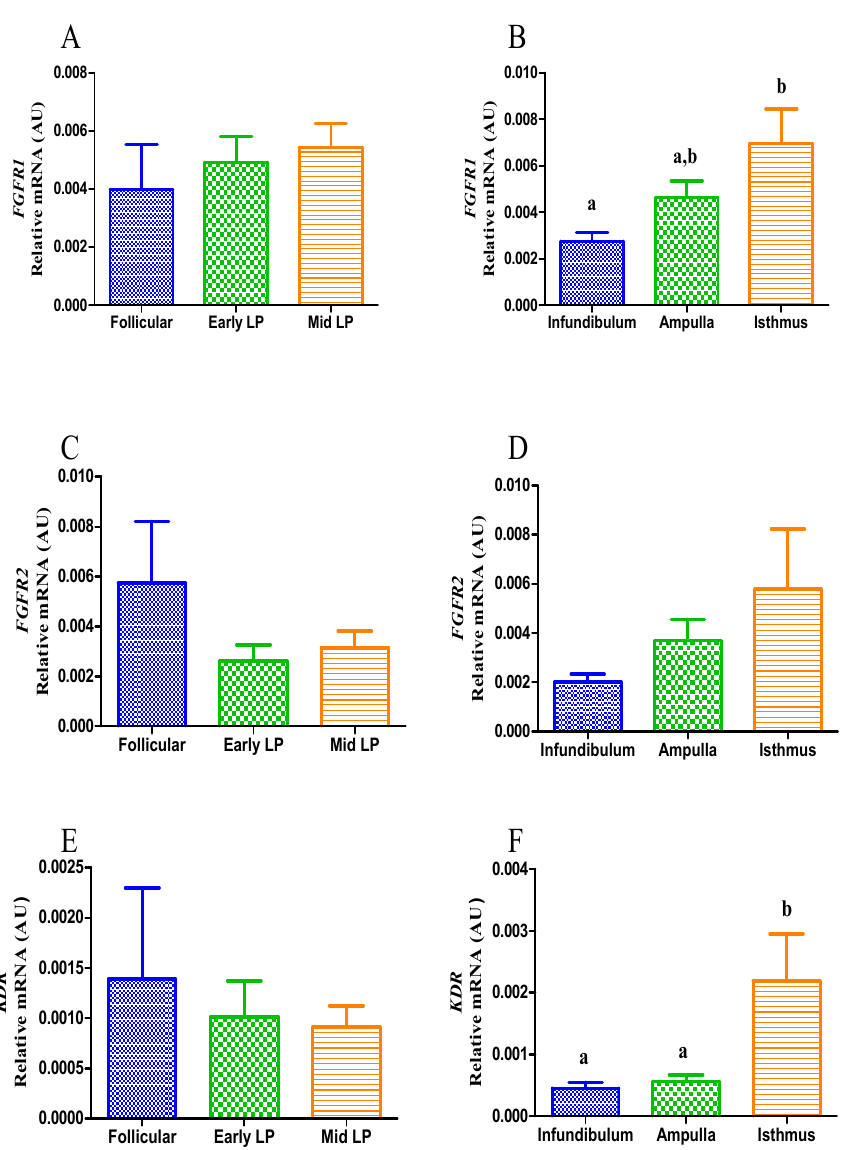
Figure 6. Relative quantification of FGFR1 , FGFR2 and KDR transcripts in the equine oviduct ( n = 5 samples for each estrous cycle phase; n = 5 for each portion of oviduct analyzed). Comparison of transcripts between the follicular phase, early-luteal phase (Early LP), and mid-luteal (Mid LP) ( A , C , E ). Comparison of transcripts between oviduct portions (infundibulum, ampulla, isthmus), regardless of the phase of the estrous cycle ( B , D , F ). Bars represent mean ± SEM. AU: arbitrary units. Different letters indicate significant differences ( p <